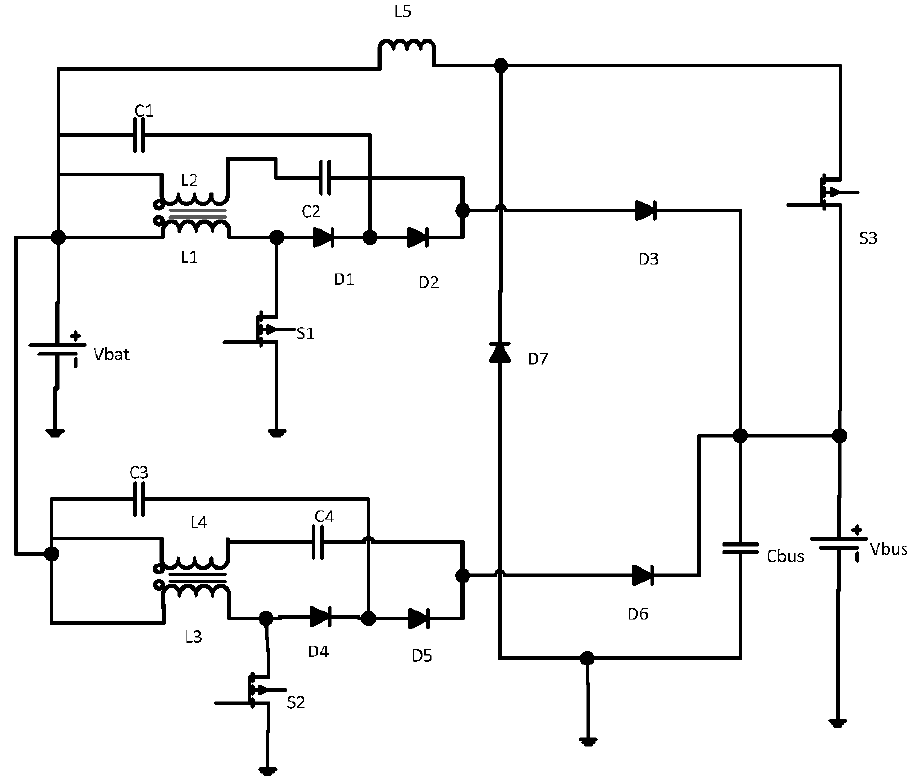
Figure 2. Proposed bidirectional DC–DC converter.